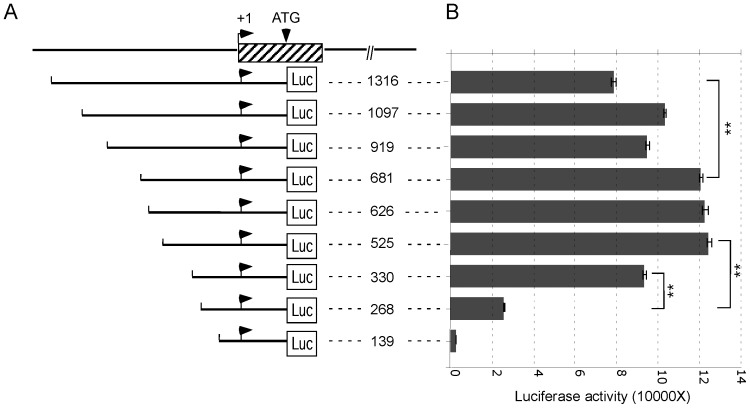
Promoter activity analyses of the GDP-fucose transporter gene.
A. Schematic representation of the luciferase reporter constructs carrying serial deletions of the upstream sequences of the GDP-fucose transporter gene in pGL-3 basic vector. The numbers indicate the upstream sequences relative to the transcription initiation site. Luciferase start codon is indicated. B. Luciferase activity assays of the constructs described in A. The constructs containing various upstream promoter sequences as in A were transfected into HEK293 cells. After 24 h, the cells were harvested for whole cell lysates, which were used for luciferase activity analyses with Luciferase Assay Systems. The relative luciferase activity was measured by microplate luminometer. Error bars represent standard deviation from four independent experiments. **, p<0.01 (t-test).